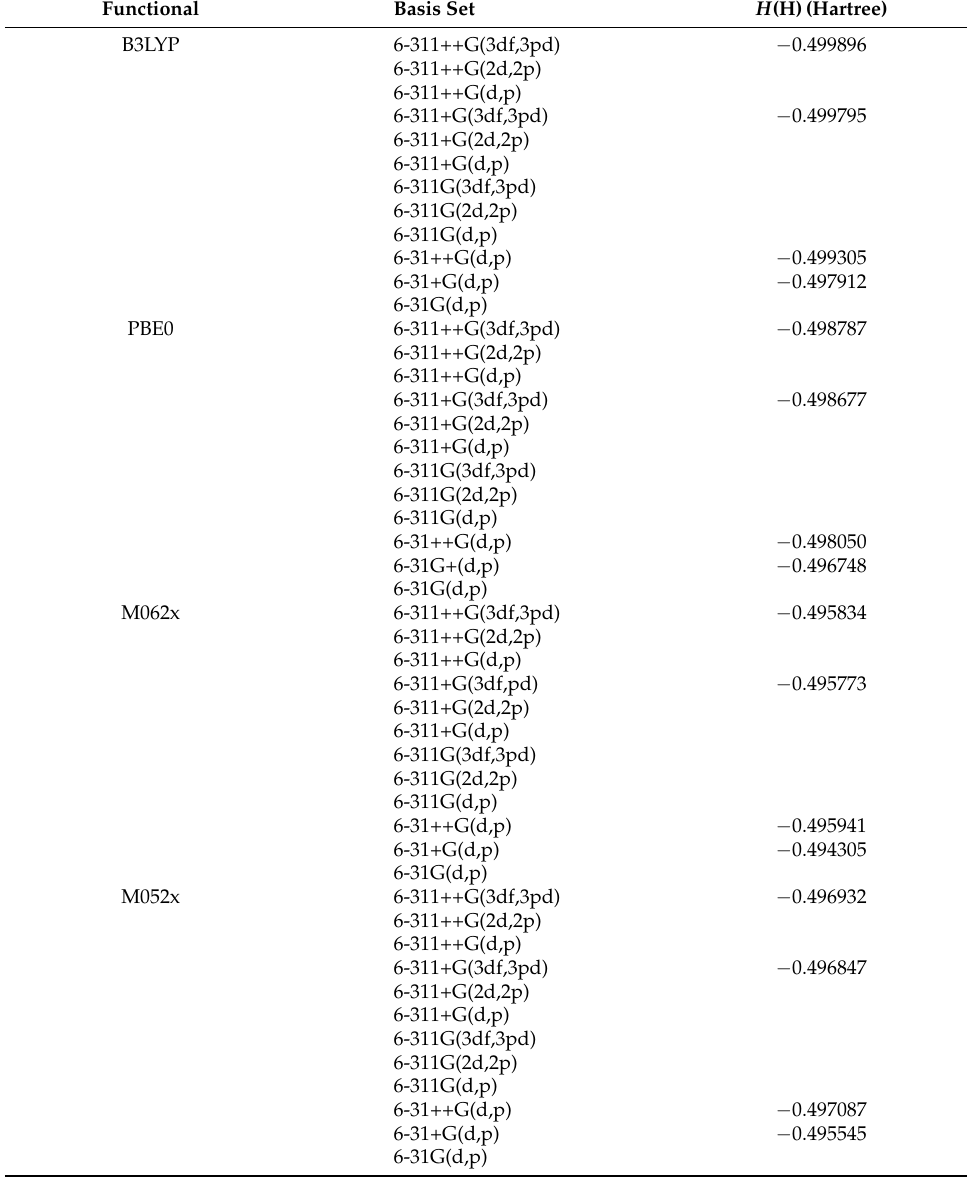
Table 2. Enthalpies of the H-atom at T = 298.15K obtained by adding the thermal correction of 0.002361hartree (common for all compound model chemistries from GAUSSIAN 16) to the electronic energies, computed as indicated below. As visible here, notwithstanding the different number of basis functions, the results using the basis sets 6-311+G(d,p) and 6-311G(d,p), and 6-31+G(d,p) and 6-31G(d,p) are identical. Likewise, including more polarization functions, G(d,p) → G(2d,2p) or 6-311++(3df,3pd), has no impact on the values presented here. Functional Basis Set H (H)(Hartree)